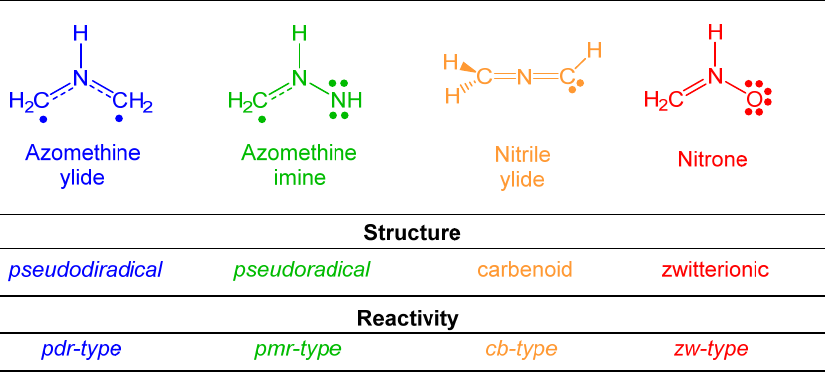
Figure 1. The four representative reactivity models in 32CA reactions.